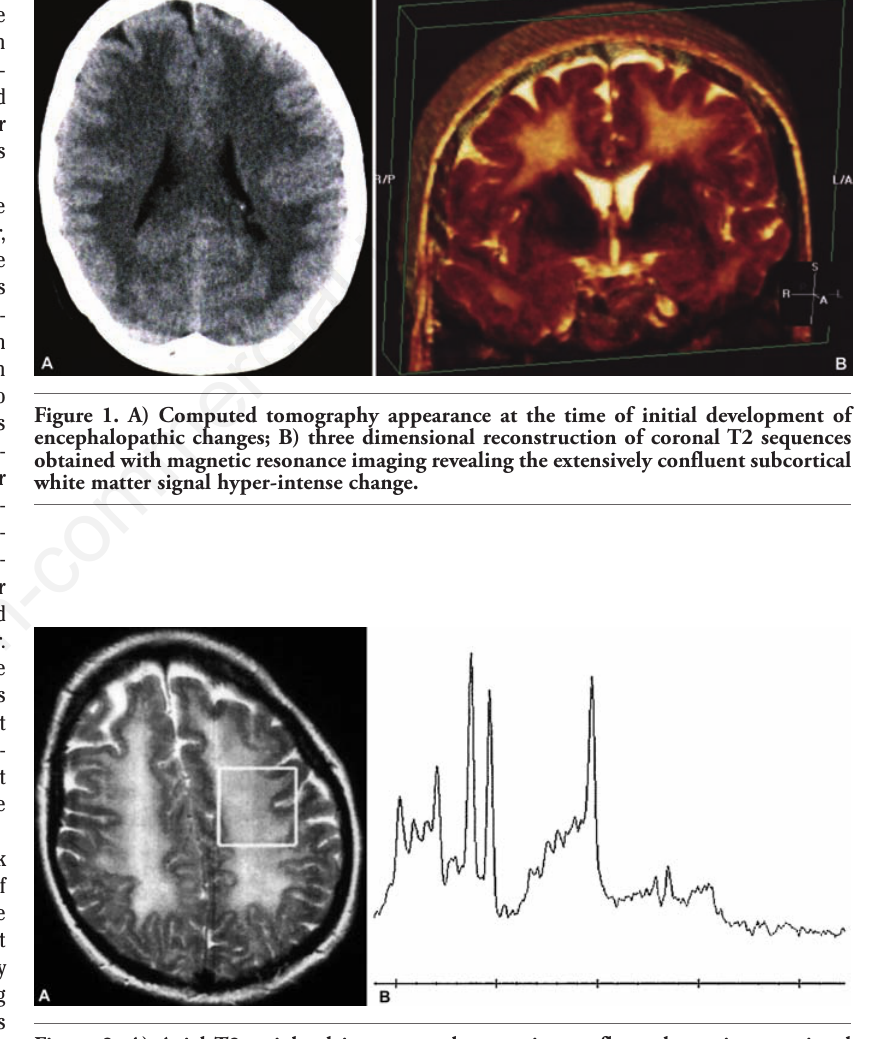
Figure 2. A) Axial T2 weighted image reveals extensive confluent hyper-intense signal abnormality throughout the subcortical white matter with no obvious signal change with- in the cortex. The white box within the left semi-centrum ovale subcortical white matter represents the voxel used for generating magnetic resonance spectroscopy, shown in figure two; B) magnetic resonance spectroscopy of the subcortical white matter revealing an abnormally high peak for creatinine and choline downstream and to the left of the main central NAA peak with a small yet abnormal presence of a lactic acid peak upstream from the NAA